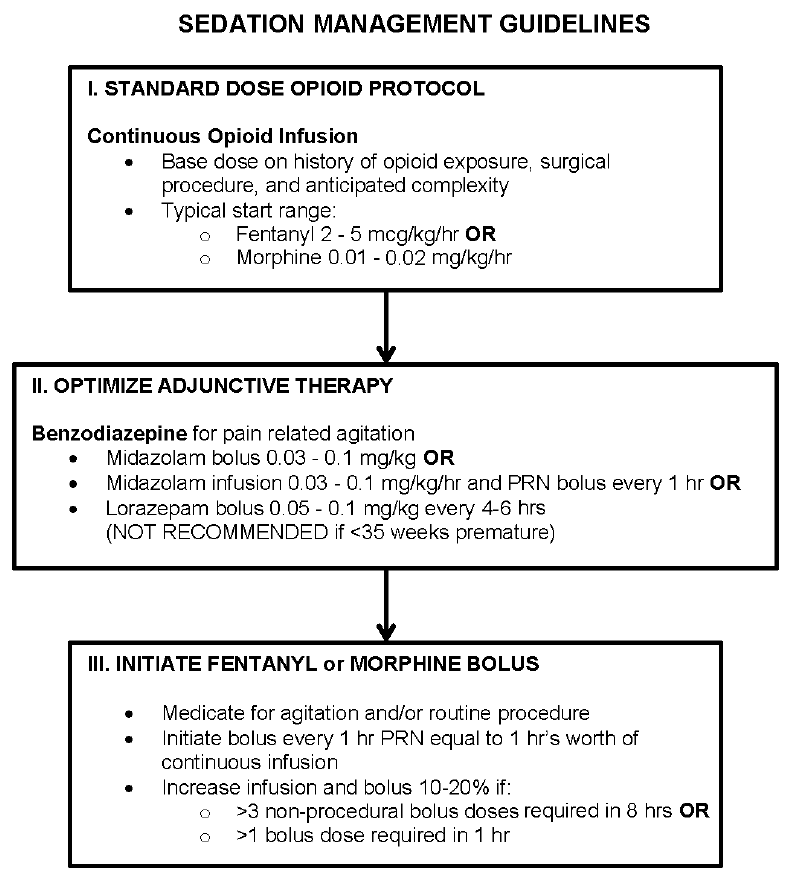
Figure 1. Prolonged Pain and Sedation Management Guidelines. Simplified summary of prolonged pain and sedation management is adapted from the Boston Children’s Hospital Patient Care Manual on Postoperative Pain Management. Continuous infusions of opioids and benzodiazepines are recommended for prolonged sedation. Guideline illustrates that sedation can be accomplished using various drugs and doses depending on individual patient’s needs, as well as physician and / or care service preference. There is no single, uniform sedation approach. Abbreviations: PRN, pro re